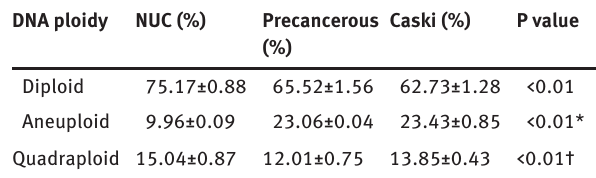
Figure 2: Cell cycles analyzed by flow cytometry. (a) DNA histogram from NUC cell group showed: G0/G1 = 67.07%, S = 25.92%, G2/M = /G = 38.03%, S =32.74 %, G 7.02%. (b) DNA histogram from precancerous cell group showed: G 0 1 cell group showed G /G = 52.50%, S = 41.75%, G /M =5.75 %. 0 1 2 /G , S and G /M phases among Table 1: The percentage of cells in G Table 2: Comparison of DNA ploidy among the NUC, precancerous 0 1 2 NUC, precancerous and Caski cell groups ( x s ± ). and Caski cell groups ( x s ±